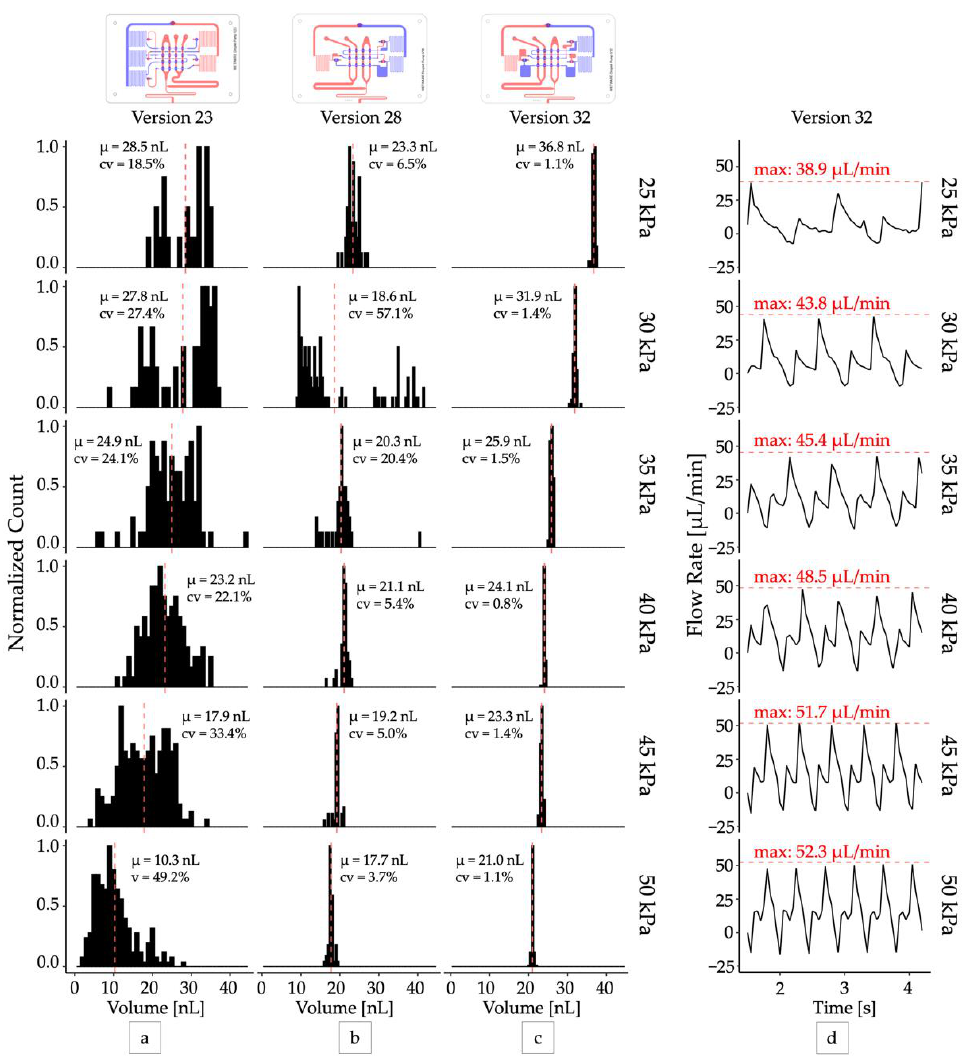
Figure 2. Optimizing droplet monodispersity. Distributions of droplet volumes produced by design iterations ( a ) Version 23: five-inverter two chamber pump, ( b ) Version 28: three-inverter single chamber pump with capacitors, ( c ) Version 32: three-inverter single chamber pump with larger capacitors. All distributions were sampled at steady state with N > 40. ( d ) The total output flow rate produced by the optimized droplet generator (version 32). The peak flow rate (red dashed lines) delivered by each pump cycle increased from 38.9 µL/min to 52.3 µL/min as operating vacuum increased from 25 kPa to 50 kPa.